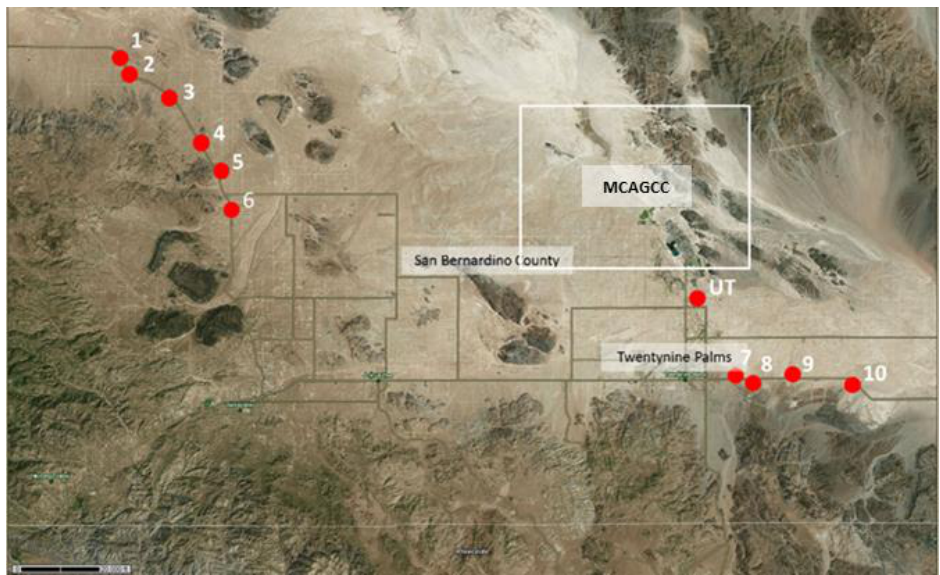
Figure 4. Sampling location (indicated as red dots) near Twentynine Palms MCAGCC (within white square). Several subsamples were collected at each indicated sampling site (site UT = Utah Trail).